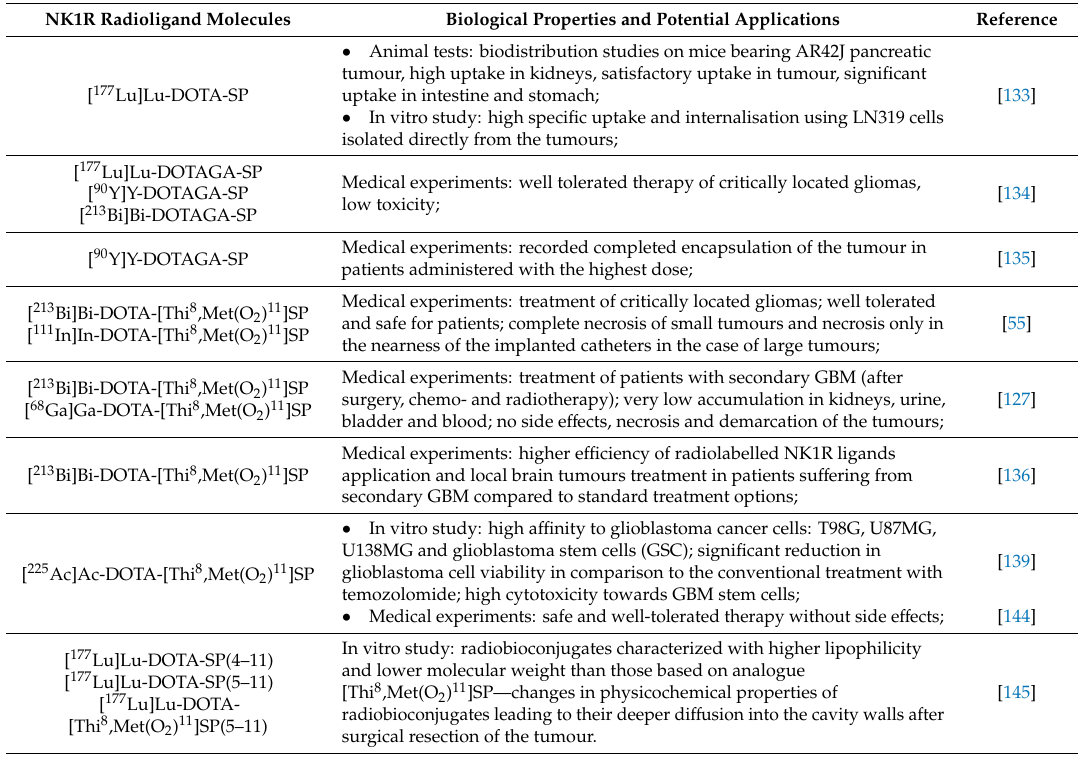
Table 5. Structure and potential application of NK1R therapeutic radioligands based on SP and its analogues or